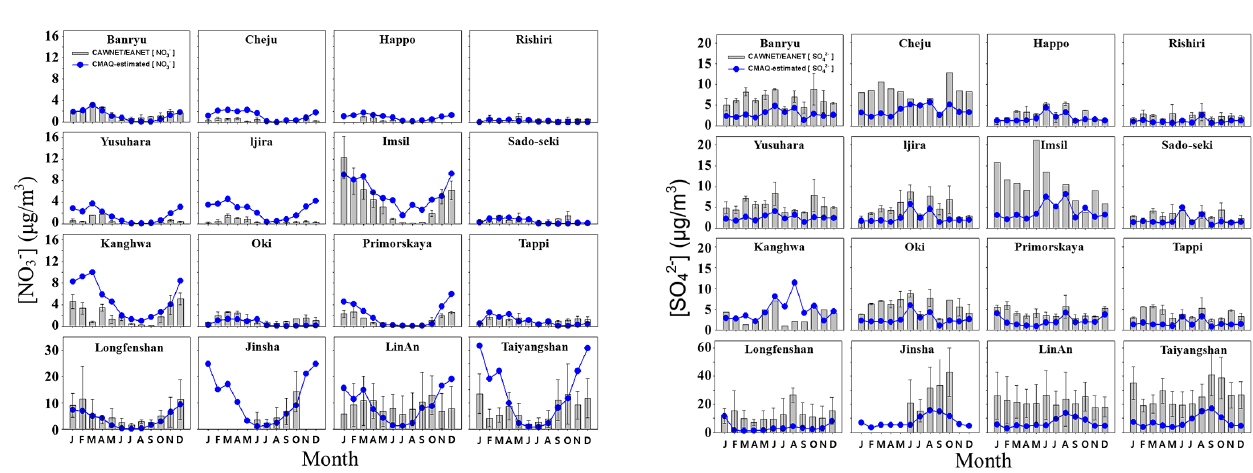
Fig. 5. Same as Fig. 3 but for SO 2 − at 16 EANET/CAWNET Fig. 4. Comparisons between monthly averaged EANET/CAWNET 4 concentration of NO − (gray bars) and monthly averaged 3 CMAQ-estimated concentration of NO − (blue-dotted lines). The 3 comparisons were made at 16 EANET/CAWNET sites. For the EANET particulate composition data, the black bars indicate the ranges of maxima and minima of NO − concentrations at nine 3 Japanese EANET sites and ± σ (standard deviation) of NO − con- 3 centrations at three Korean EANET sites, respectively. Only max- ima and minima of daily and biweekly data were obtained from three Korean and nine Japanese EANET sites, respectively. This is because at the nine Japanese sites only biweekly data were avail- able. In contrast, at the three Korean sites the EANET concentra- tions were available on daily basis. For the CAWNET particulate composition data, the standard deviations (black bars) were ob- tained from Zhang et al. (2012b).